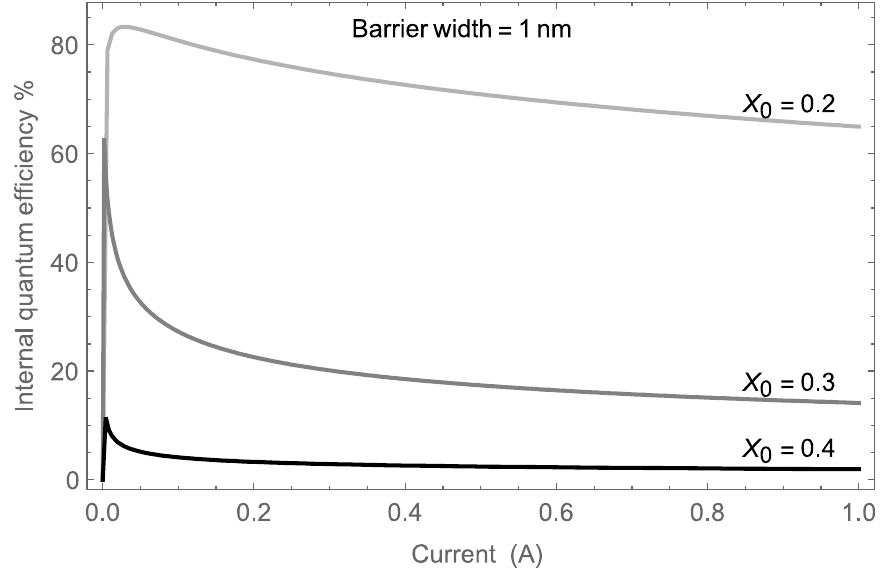
Figure 18. Internal quantum efficiency as a function of current at barrier width 1 nm.